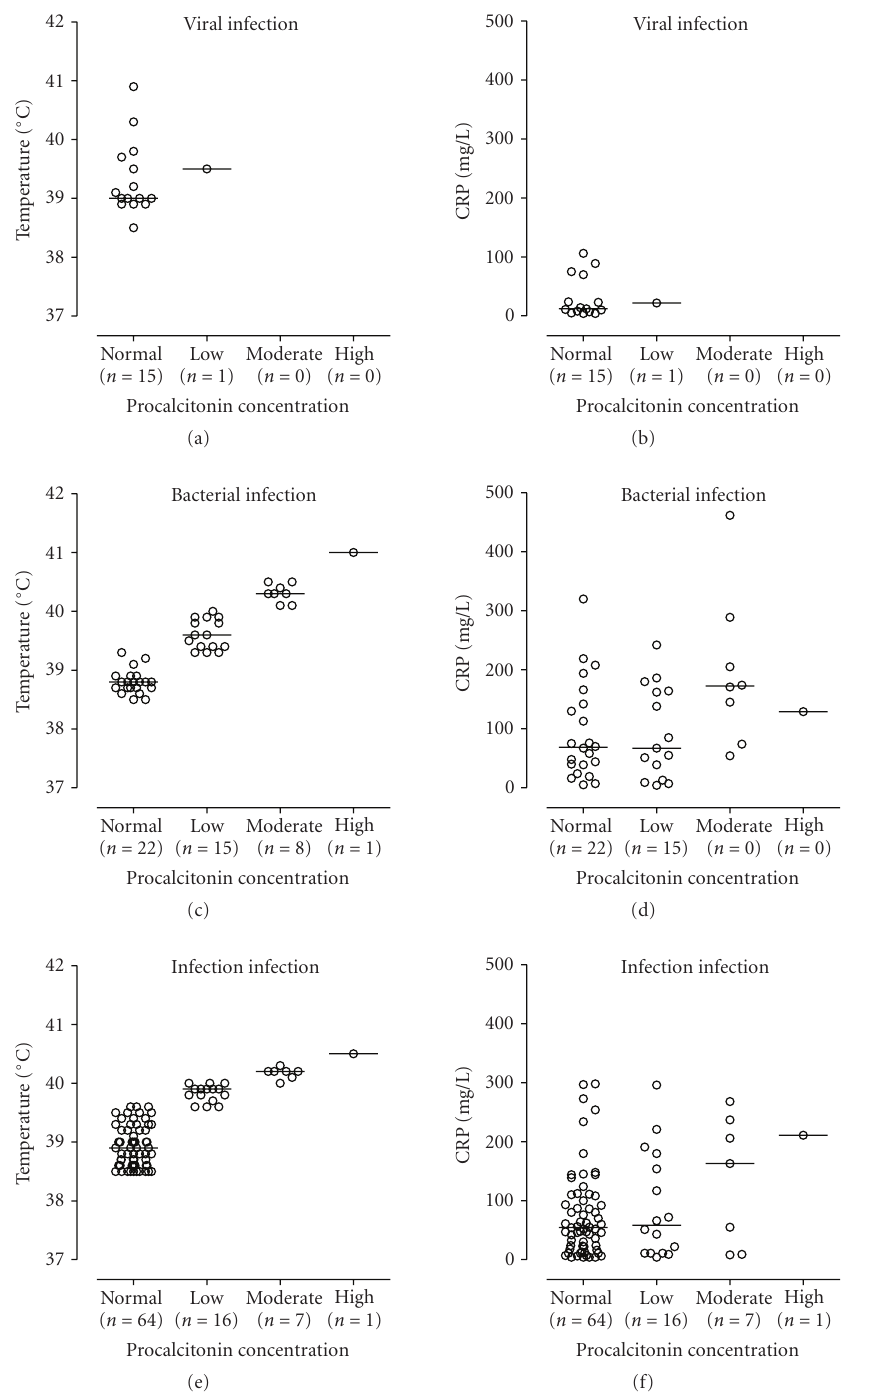
Figure 2: Left panel. Relationship between body temperature on admission and procalcitonin levels on admission. (a) Relationship in patients with a documented viral cause of fever ( n = 16). No statistical analysis performed. (c) Relationship in patients with a documented bacterial cause of fever ( n = 46). Overall, P -value < . 0001 (Kruskal Wallis), specified per PCT result: Normal versus Low P < . 0001 (Mann- Whitney U test). Normal versus Moderate P < 0 . 0001 (Mann-Whitney U test), and Low versus Moderate P = . 0001 (Mann-Whitney U test), (e) Relationship in patients with a likely infection ( n = 88). Overall, P -value < . 0001 (Kruskal Wallis), specified per PCT result: Normal versus Low P < . 0001 (Mann-Whitney U test), Normal versus Moderate P < . 0001 (Mann-Whitney U test), Low versus Moderate P = . 0003 (Mann-Whitney U test). Right panel. Relationship between C-reactive protein and procalcitonin levels on admission. (b) Relationship in patients with a documented viral cause of fever ( n = 16). No statistical analysis performed. (d) Relationship in patients with a documented bacterial cause of fever ( n = 46). Overall, P -value P = . 12 (Kruskal-Wallis). (f) Relationship in patients with a likely infection ( n = 88). Overall, P -value . 36